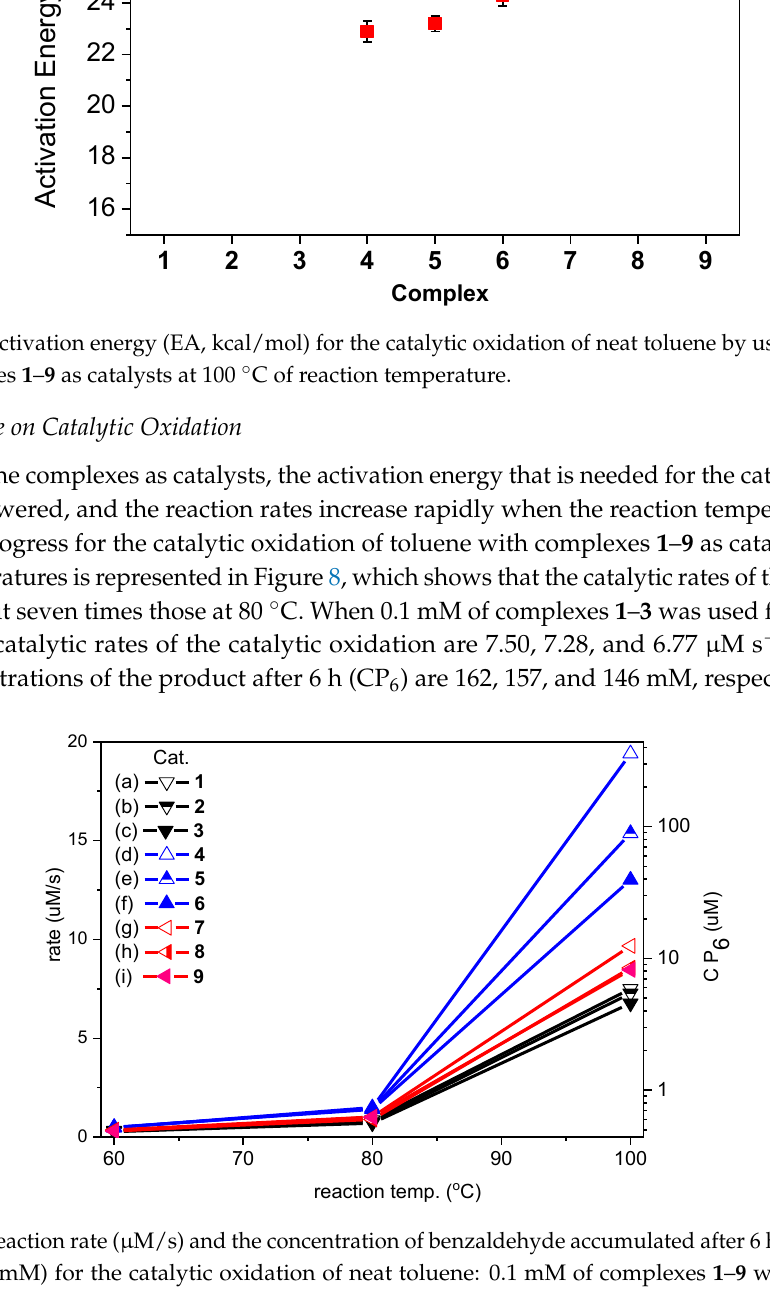
Table 3. Reaction Conditions of Catalytic Oxidation for Toluene.